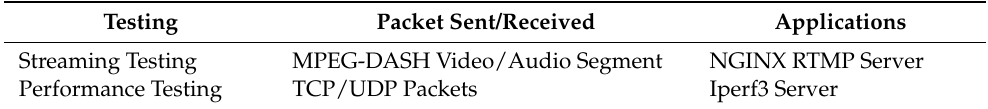
Table 3. Communication